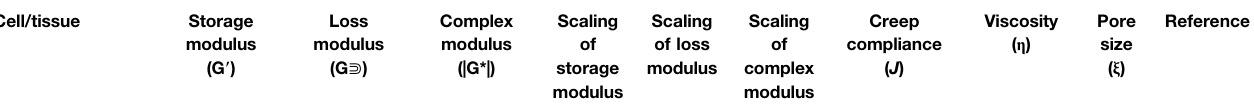
Human glioma cell line U373 (grade